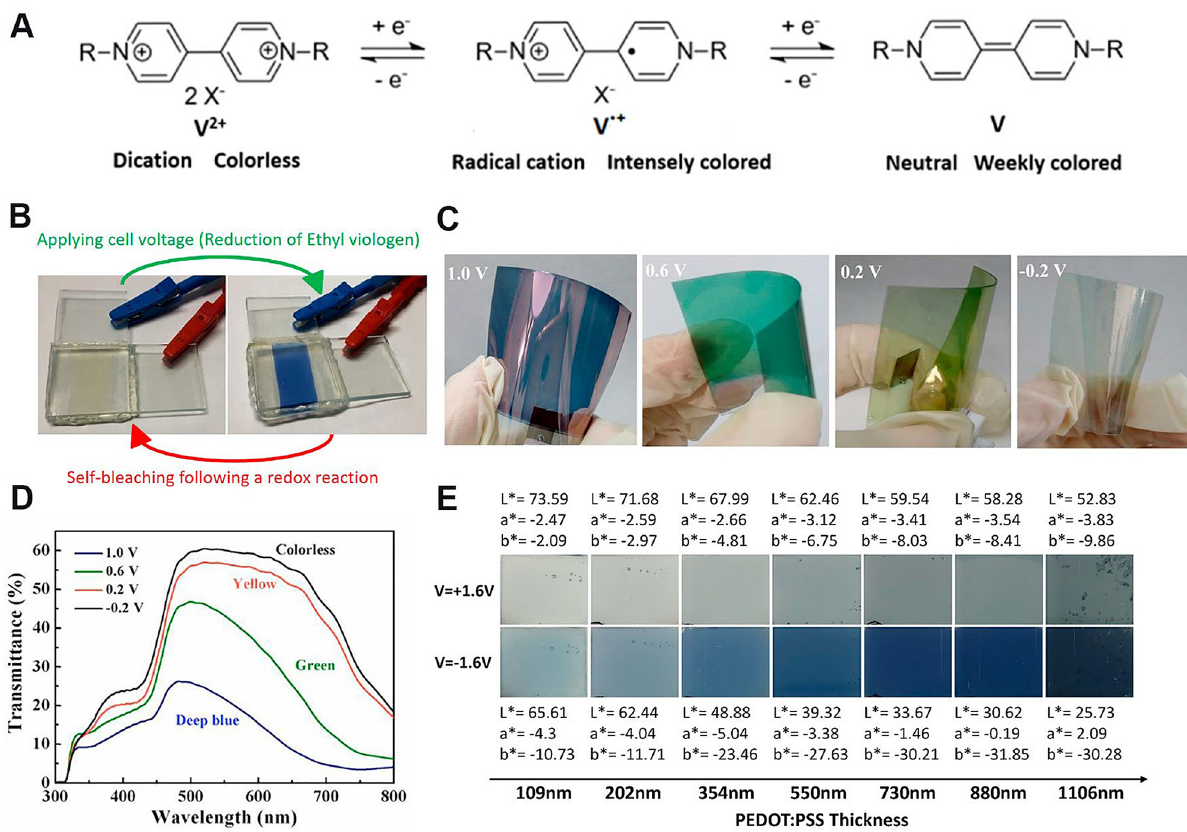
Figure 3: Characterization and demonstration of organic electrochromic materials. (A) Different redox states of viologen. (B) The photographs of ethyl viologen – based electrochromic device at bleached and colored states. (A – B) Reproduced with permission from Ref. [75]. Copyright 2019, Multidisciplinary Digital Publishing Institute. (C) The photographs of the fl exible polyaniline (PANI) fi lm electrode in its colored state at the different potentials. (D) The corresponding optical transmittance spectra of the fl exible PANI fi lm electrode at different potentials. (C – D) Reproduced with permission from Ref. [86]. Copyright 2018, Elsevier Ltd. (E)Photographsof theelectrochromicsymmetricaldisplaysbuiltfromPEDOT:PSS fi lmswithdifferentthicknesses,showinganoxidizedstate forapotentialof + 1.6Vandareduced(colored)stateforapotentialof − 1.6V.ThecorrespondingmeasuredCIEL*a*b*parametersarelabeled. Reproduced with permission from Ref. [84]. Copyright 2019, Multidisciplinary Digital Publishing